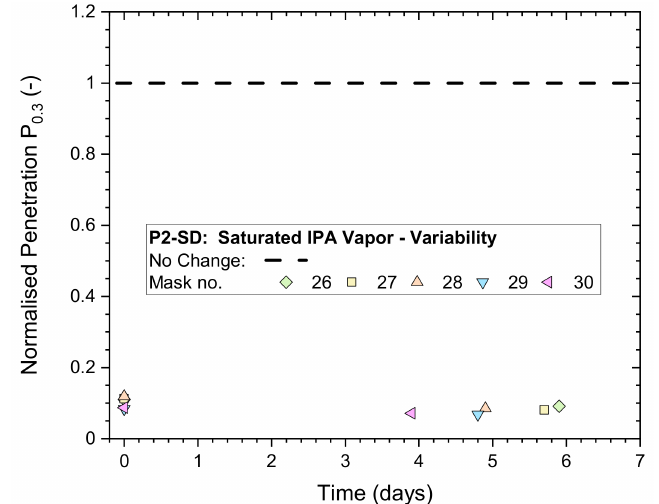
Figure 4. Normalized penetration P n0.3 from whole-mask screening tests of a P2-rated mask (P2-SD: Shanghai Da Sheng) after exposure to 5 h of saturated IPA vapor followed by 30 min of ventilation in a fume hood, measured immediately after treatment and after storage in plastic bags for up to 6 days.